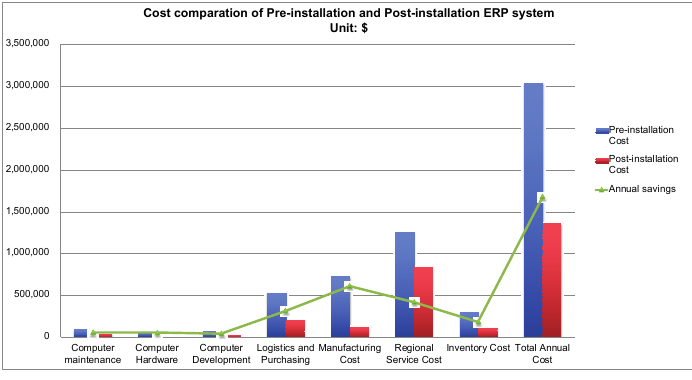
Fig. 8. Cost comparison of Pre-installation and Post-installation ERP